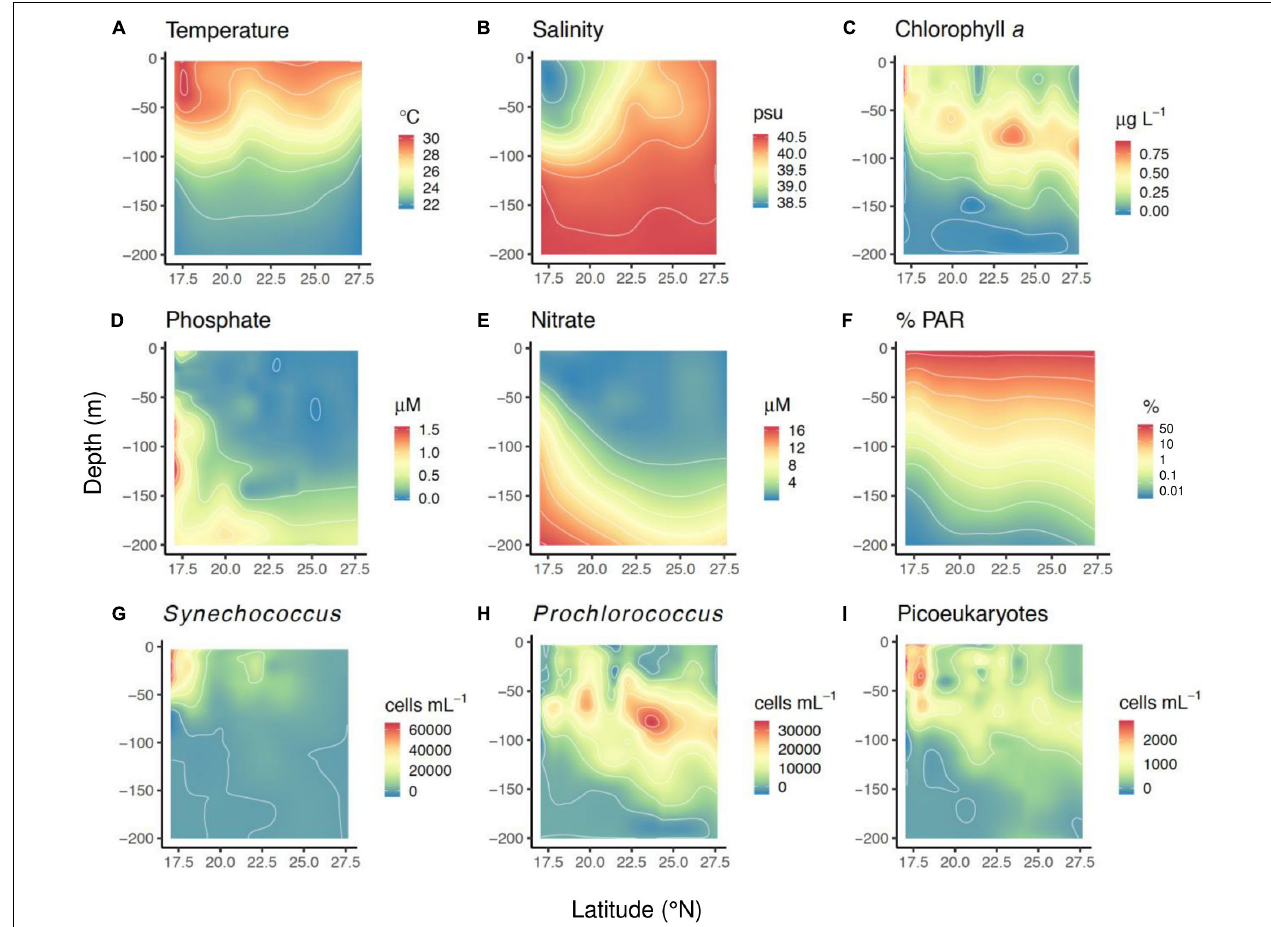
FIGURE 2 | Contour plots showing the distribution with depth and latitude of (A) seawater temperature ( ◦ C), (B) salinity (psu), (C) chlorophyll a ( µ g L − 1 ), (D) phosphate concentration ( µ M), (E) nitrate concentration ( µ M), (F) %PAR, (G) cellular abundance of Synechococcus (cells mL − 1 ), (H) cellular abundance of Prochlorococcus (cells mL − 1 ), and (I) cellular abundance of picoeukaryotes (cells mL − 1 ), as measured during the study. These plots were created fitting a two-dimensional loess model to the actual values measured at each station and depth.